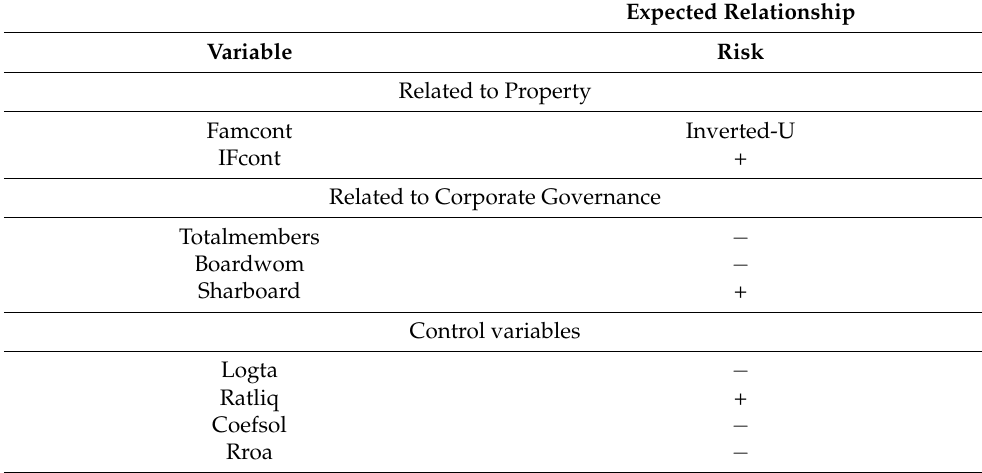
Table 10. Variables and initial